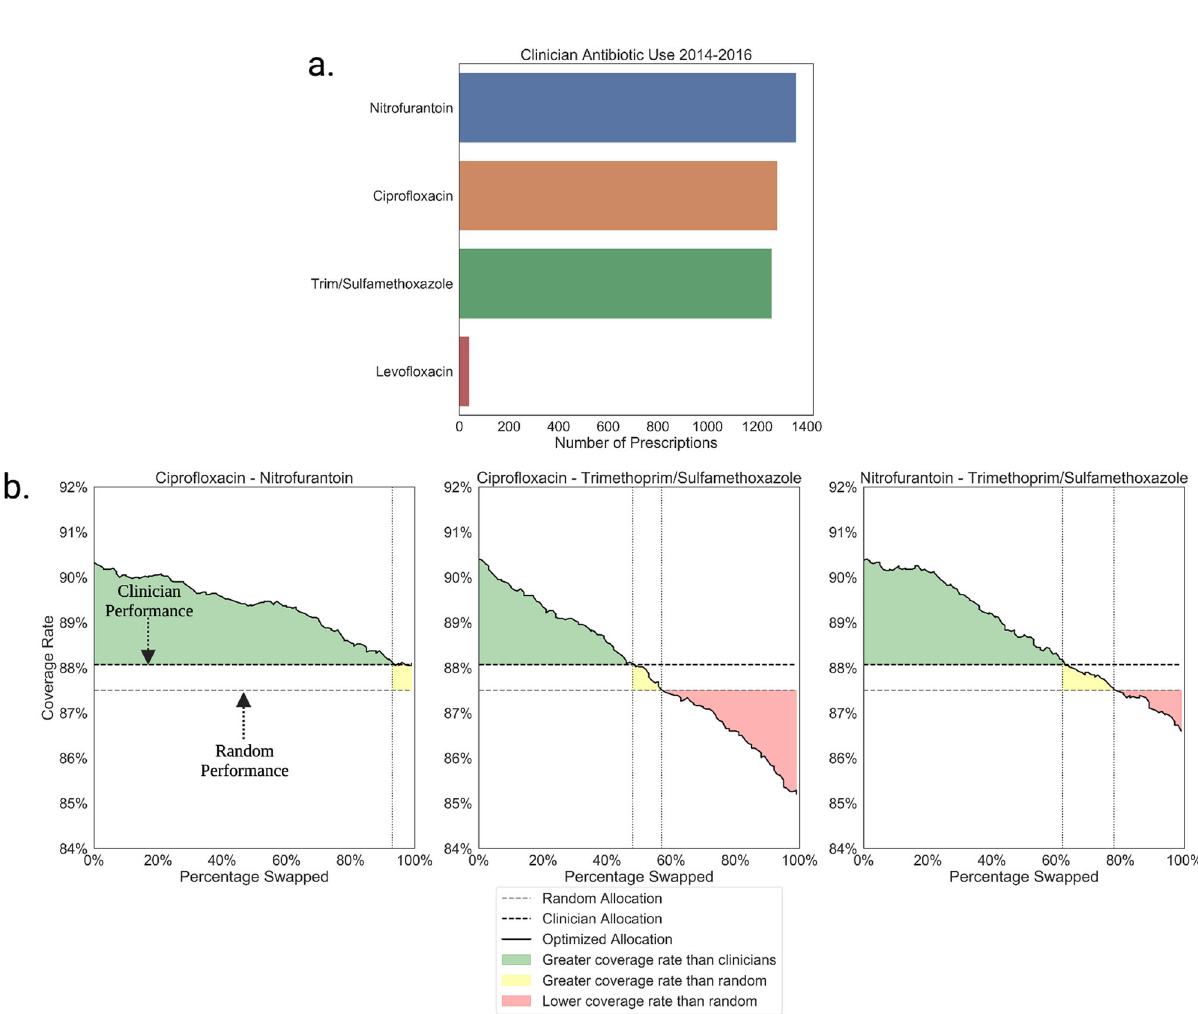
Fig. 5 Personalized antibiogram coverage rate as a function of the antibiotic budget parameters in the Boston dataset. a Held out Boston test set of uncomplicated urinary tract infection cases treated with one of the four antibiotics in the dataset. b Antibiotic sweep simulations showing the trade off between miss rate and broad-spectrum antibiotic use when antibiotic selection is optimized with personalized